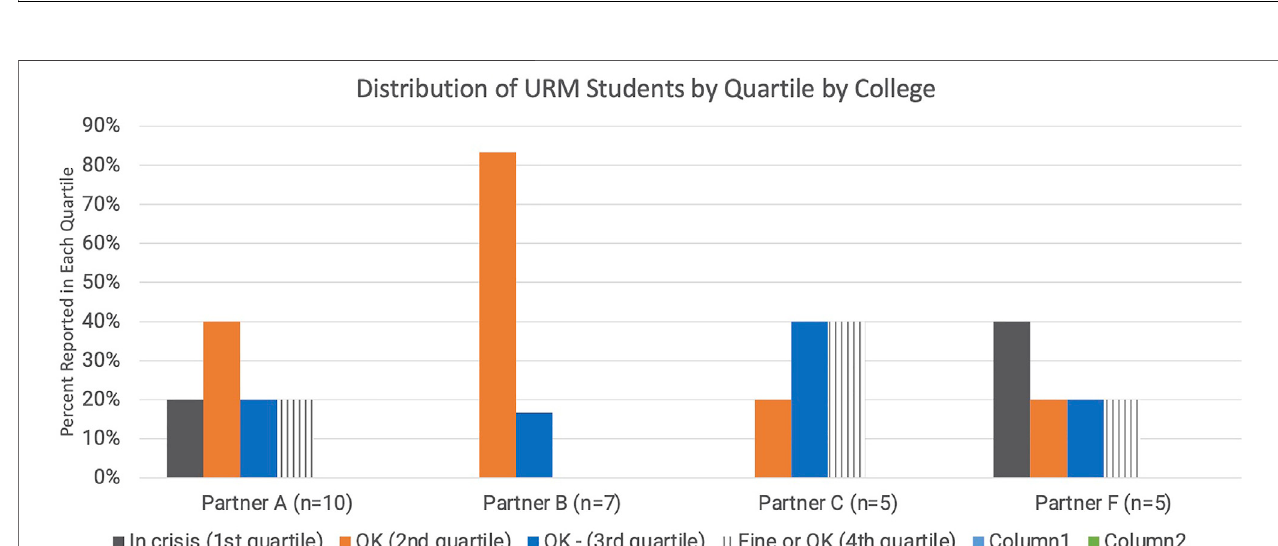
FIGURE 5 | How are Students Feeling? (By Schools – with 5 or More Survey